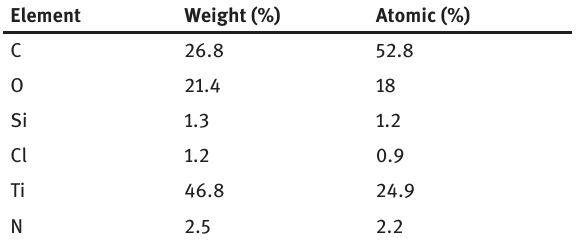
Table 2: EDX analysis of MTICl- Ti(OBu) Element